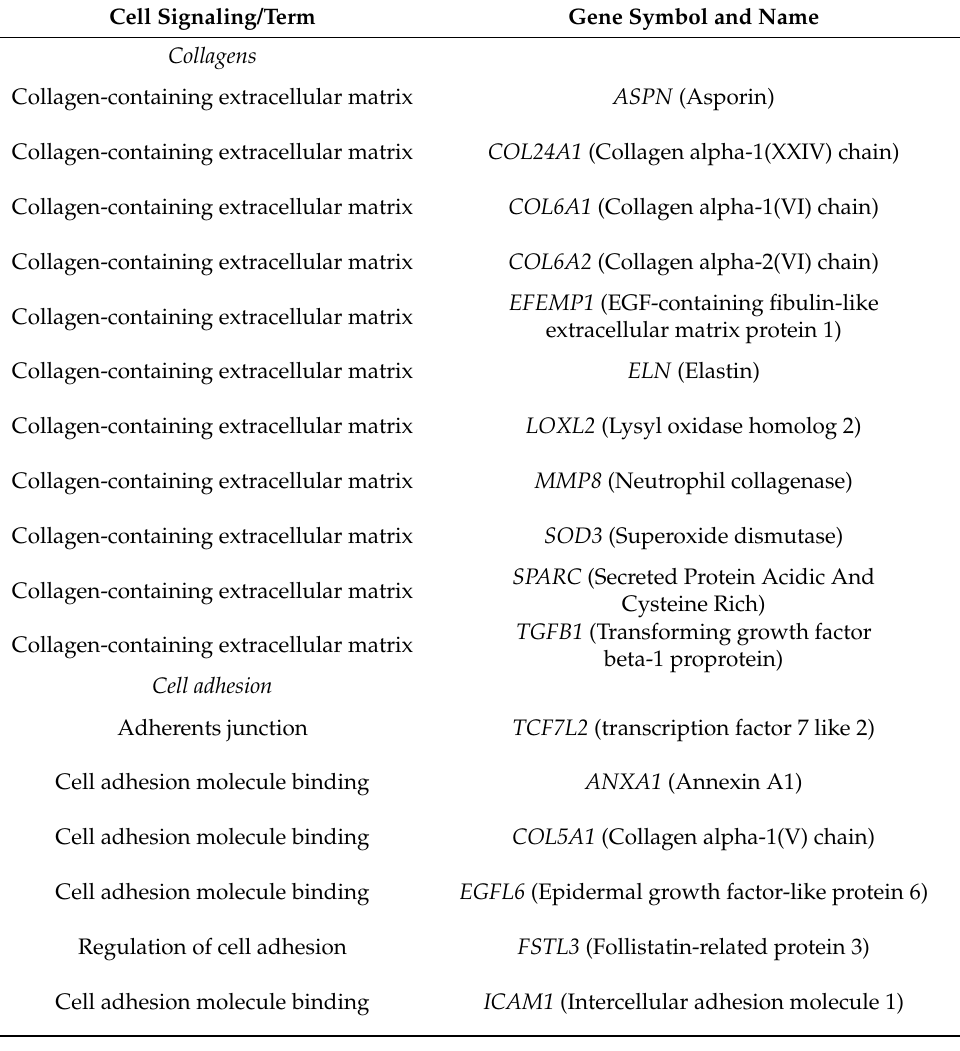
Table 3. Integrative analysis of gene expression patterns revealing ECM implication in obesity and metabolic